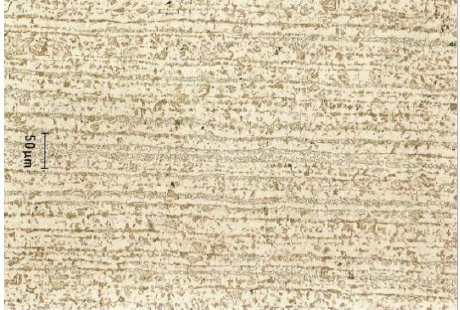
Figure 15. Structure of base material of Hardox 400 sheet.